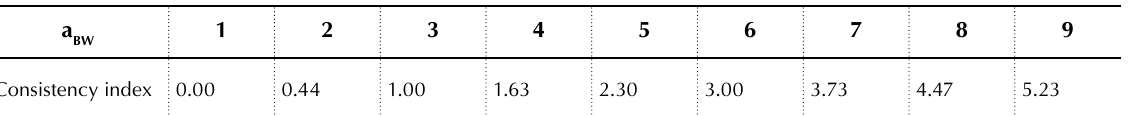
Table 1. Consistency index (CI)